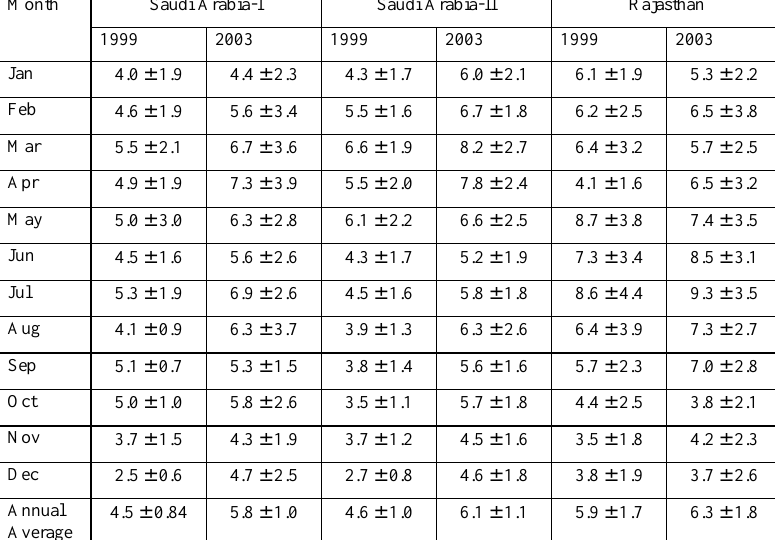
Table 2. Comparison of Monthly Mean IDDI (K). Table-2. Comparison of Monthly Mean IDDI (K)